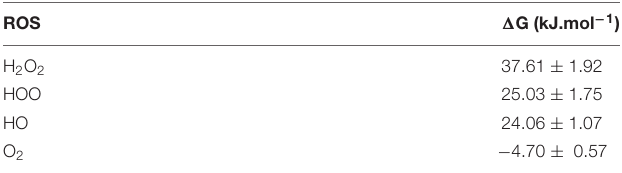
Frontiers in Pharmacology |